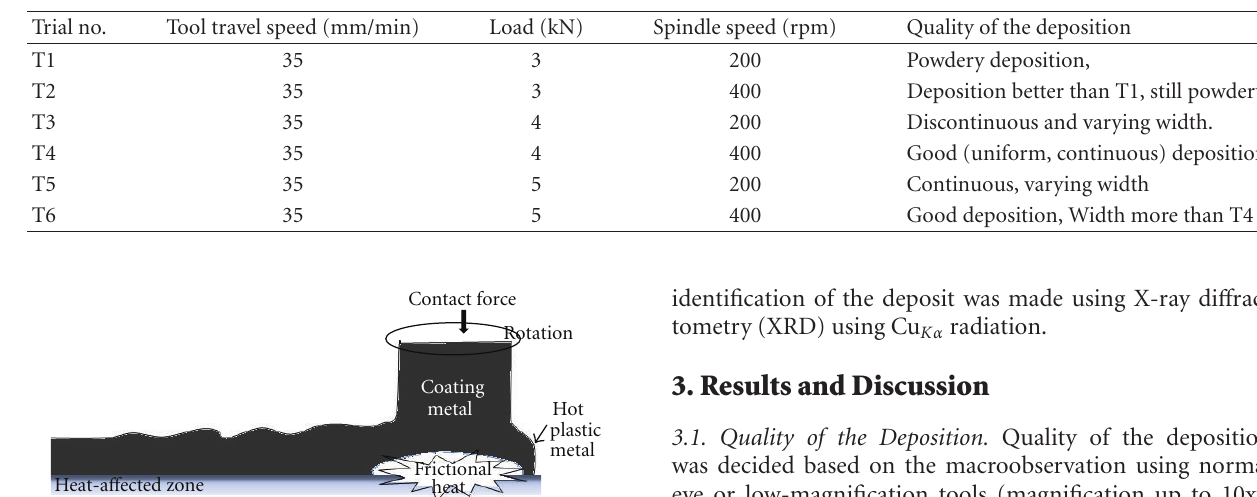
Table 1: Processing parameters for various samples and quality of the deposition.